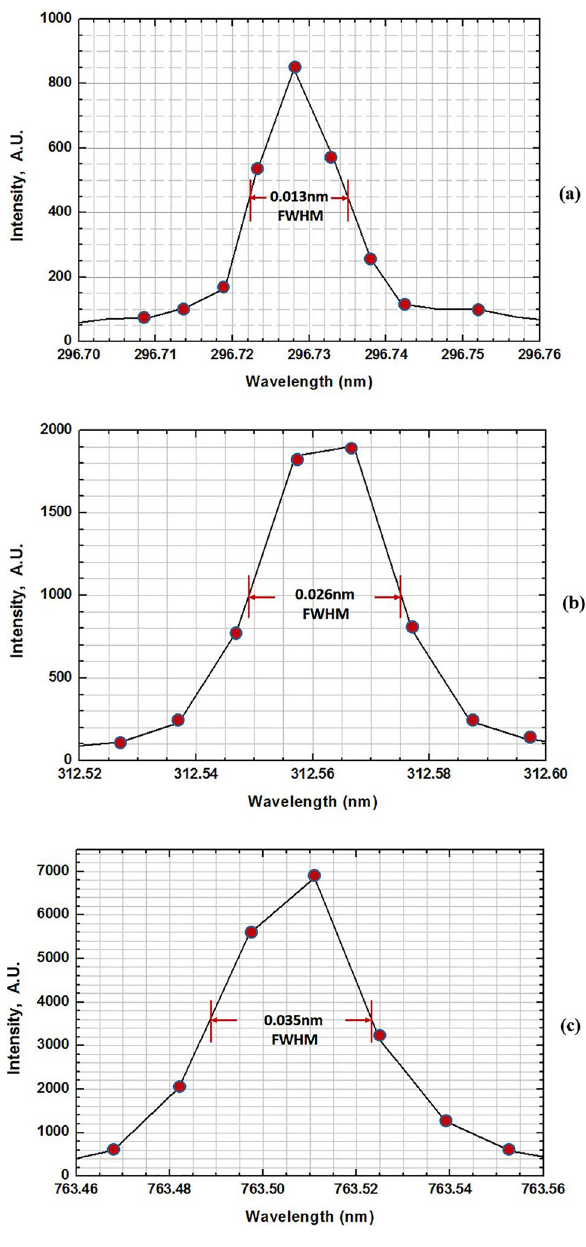
pixel (∆λ(FWHM) = 3δλ ≤ 3Δλ max ) is better than 0.005 nm/pixel, 0.010 nm/pixel and 0.015 nm/pixel in the 200–300 nm ( g = 3600 lines/mm), 300–600 nm ( g = 1800 lines/mm) and 600–1000 nm ( g = 1200 lines/mm) wavelength regions, respectively, which is consistent with the design